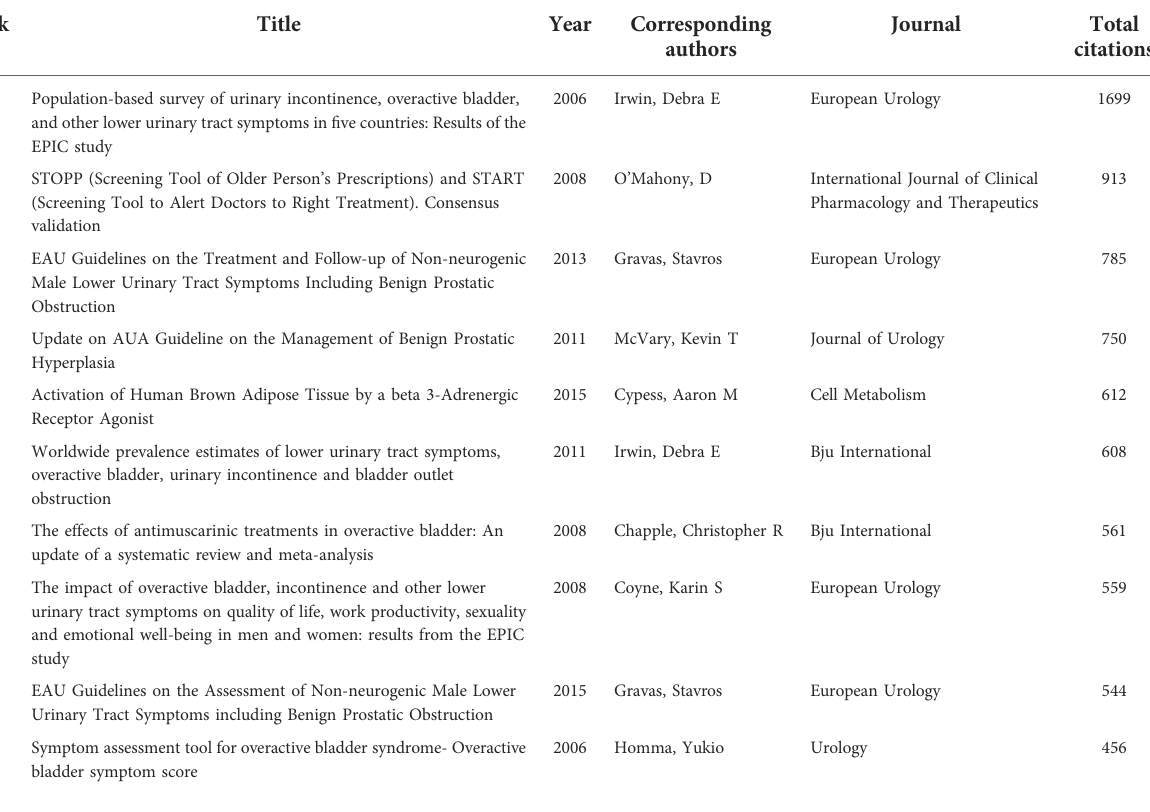
TABLE 4 Top 10 cited papers on the topic of overactive